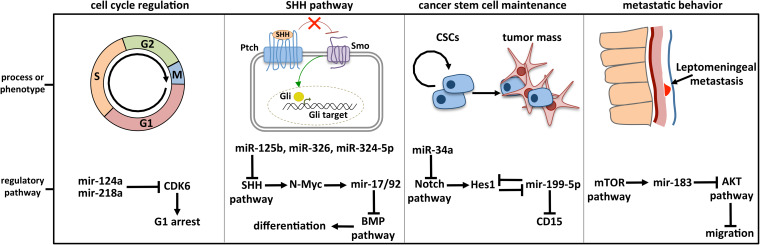
Deeply characterized cellular processes affected by miRNAs in MB. The brain-enriched miR-124a and miR-218a participate in cell cycle control by modulating the expression of CDK6, the cyclin-dependent kinase 6 crucially implicated in cell cycle progression. MiR-125b, miR-326, miR-324-5p, and MiR-17/92 cluster is included in the regulatory axis between the SHH and the BMP signaling, participating in the cell choice between proliferation and differentiation. MiR-125b, miR-326, and miR-324-5p guide the SHH pathway, modulating Smo and Gli1, respectively activator and effector of the cascade. MiR-199-5p is involved in CSC maintenance by modulating the CSC marker CD15 and Hes1, the main Notch downstream effector with which a negative regulative feedback loop is established. Notch signaling is also controlled by miR-34a, at the level of the ligand Dll1. The retinal miR-183 is part of the regulative axis between mTOR pathway, from which it is activated, and AKT pathway involved in cell migration.